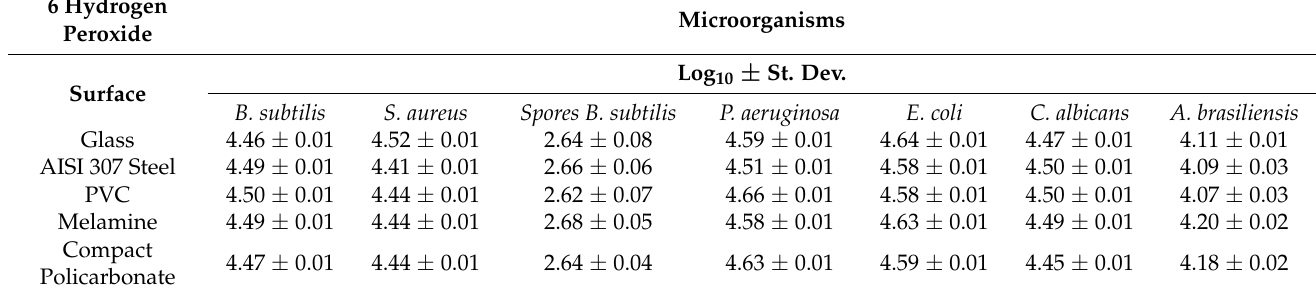
Table 2. Log 10 reduction index measured by disinfectants’ efficacy test method. The tests were performed using a contact time of 10 min. Each test was done in triplicate on three different days. The Log 10 reduction index was calculated. The acceptance criteria, in accordance with USP 35 <1072>, were a Log 10 reduction ≥ 3, in the case of bactericidal/fungicidal activity; and a Log 10 reduction ≥ 2, in the case of sporicidal